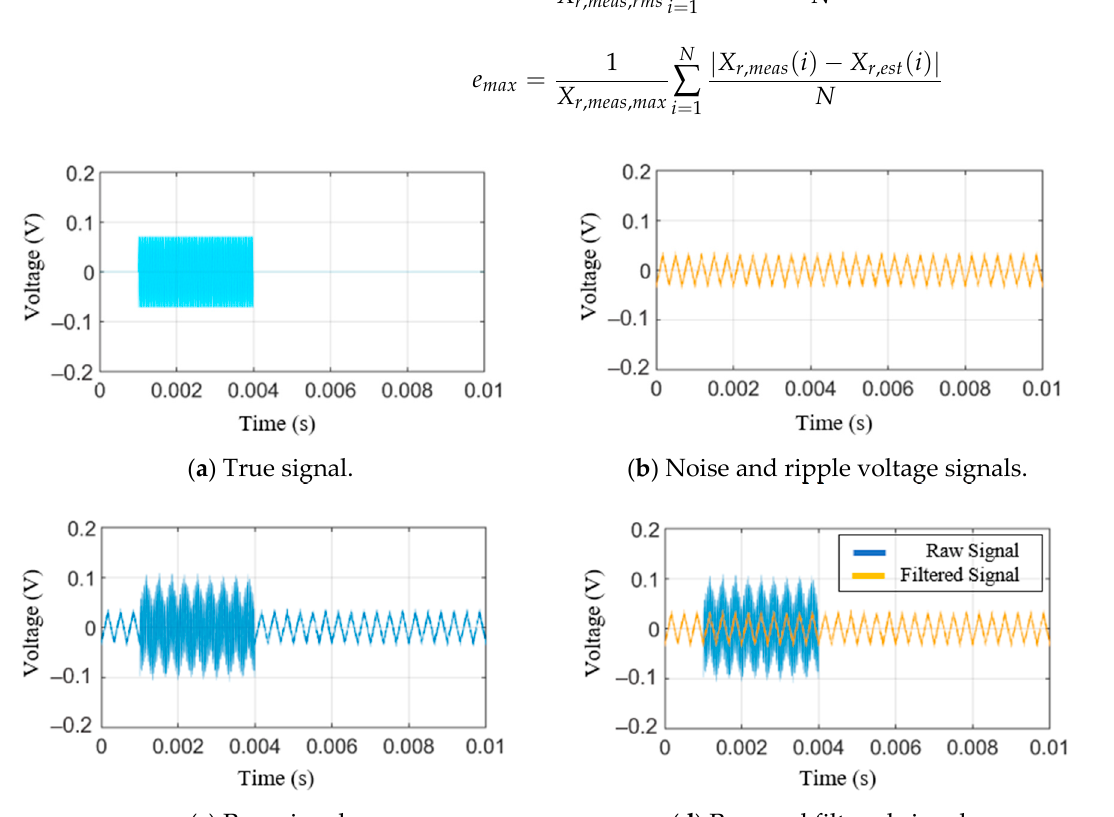
Figure 4. Simulation results of the classical Kalman filter.